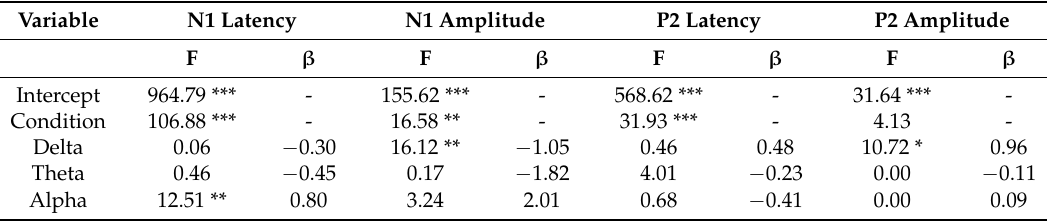
Table 2. F-statistics and regression coefficients ( β ) for each fixed effect from linear mixed-effects regression models for N1–P2 latencies and